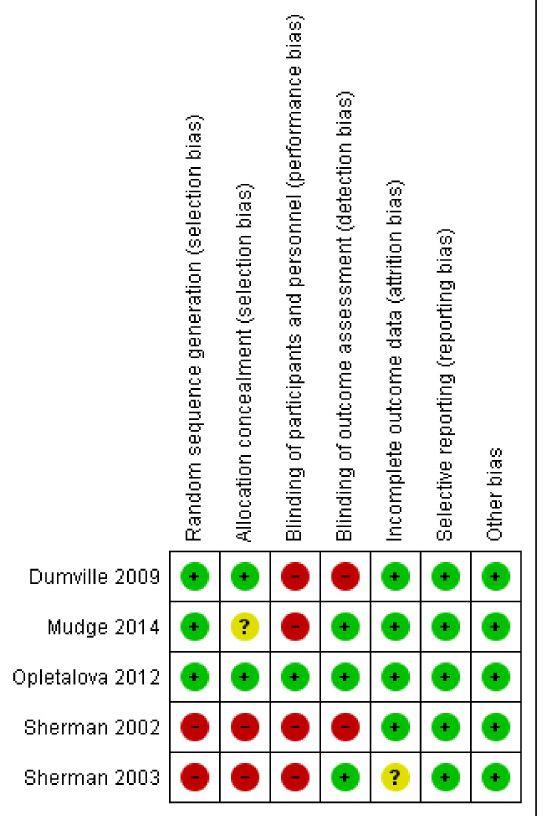
Figure 3. Risk of bias summary. The green color indicates low risk of bias, yellow color indicates unclear risk of bias and red color indicates high risk of